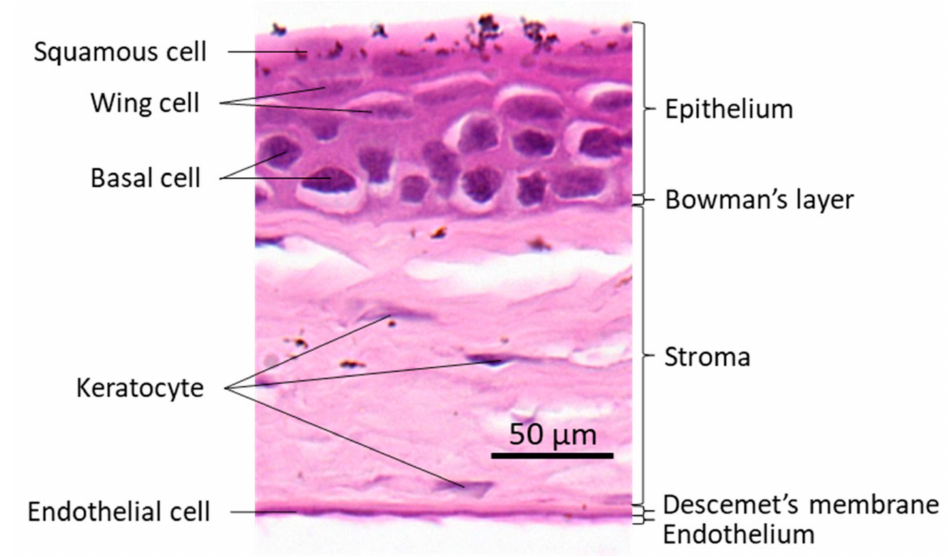
Figure 1. Mouse corneal structure and cell types.